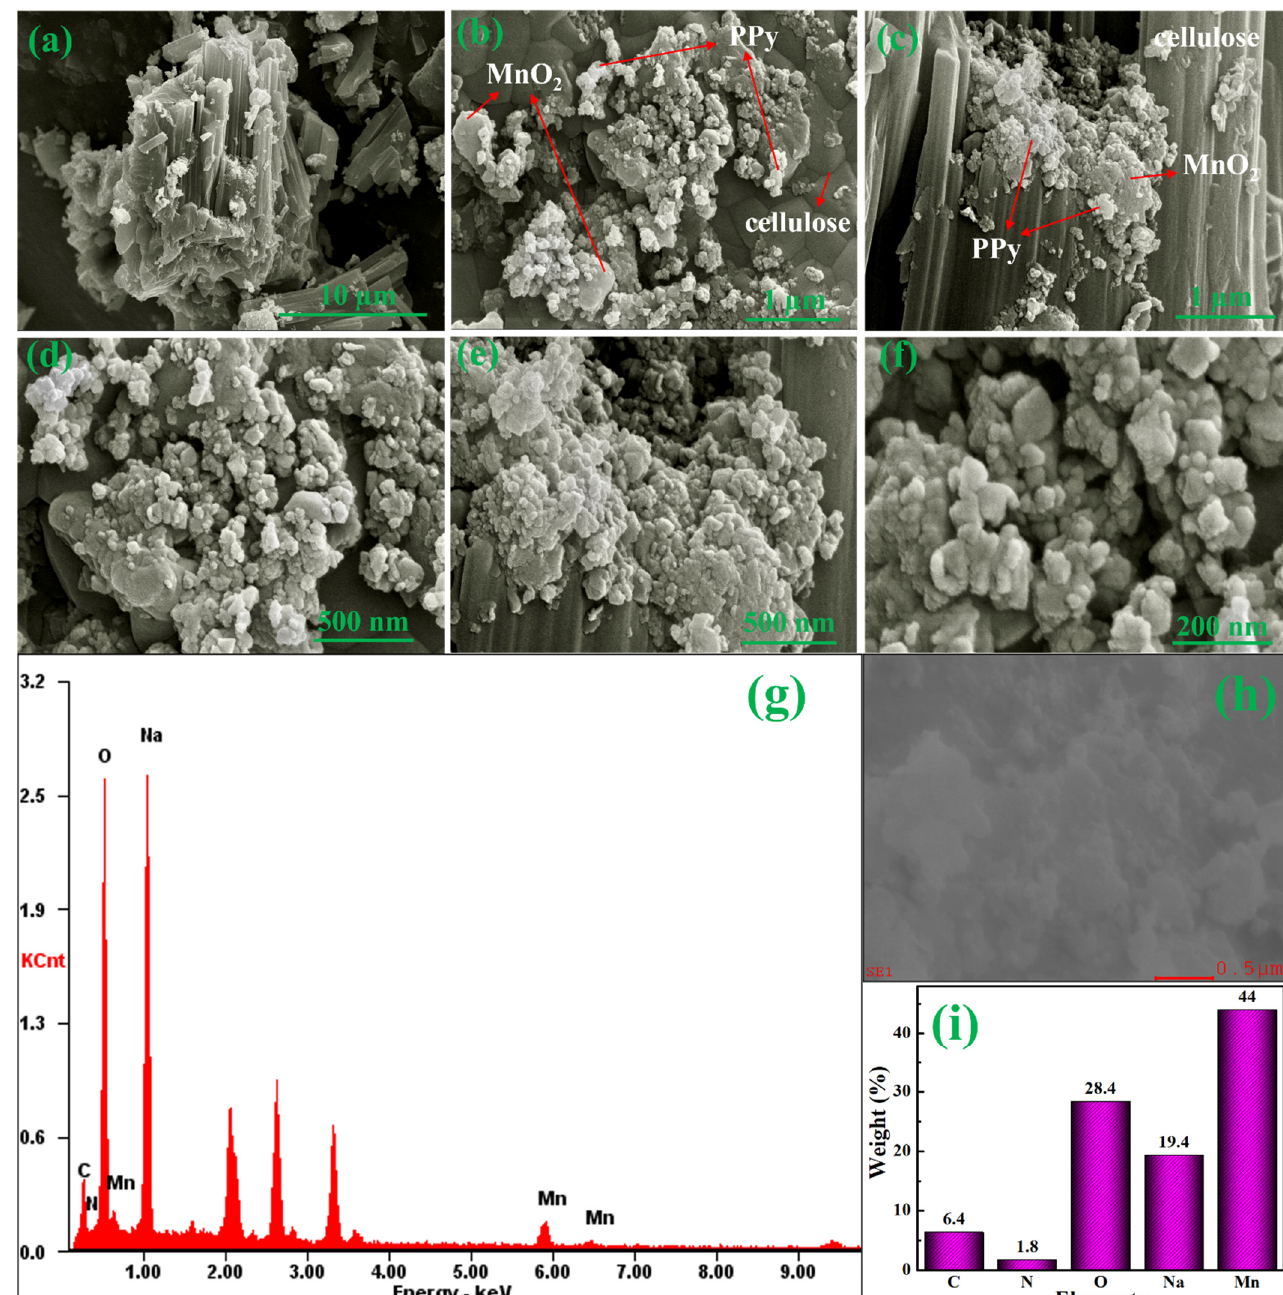
Figure 8. FE-SEM images of MnO 2 @CE/PPy at the magnification of ( a ) 10 µ m, ( b ) 1 µ m, ( c ) 1 µ m, ( d ) 500 nm, ( e ) 500 nm, ( f ) 200 nm, and ( g – i ) EDAX profile with elemental percentage by